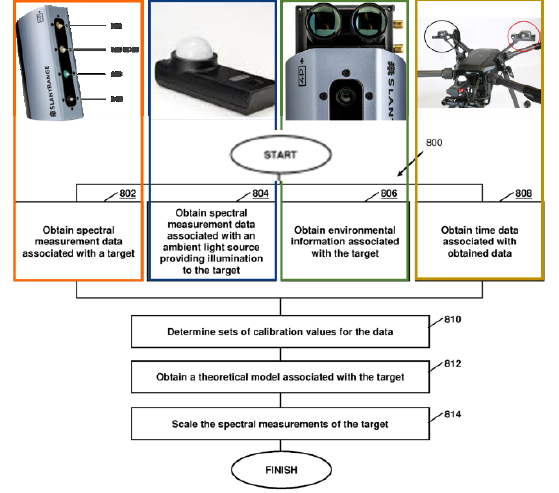
Figure 1. The workflow of the calibration procedure implemented by Slantrange and its relation to the sensor